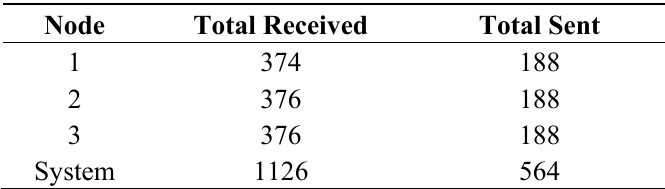
Table 9. Messages sent and received in dynamic